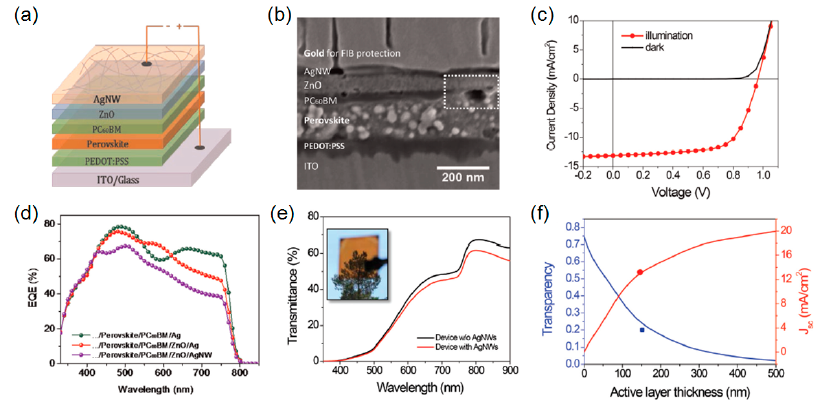
Figure 3. ( a ) Schematic structure of the devices with solution-processed top AgNWs. ( b ) Cross sectional SEM image of the whole device stack. The white dashed rectangle shows the area where perovskite is not covered by [6,6]-phenyl C 61 -butyric acid methyl ester (PCBM 60 ). ( c ) J - V curves of the devices measured under illumination (red curve) and in the dark (dark curve). ( d ) External quantum efficiency (EQE) characteristics of the three types of devices studied in this work. ( e ) Transmittance spectra of the device without and with AgNW top electrodes, which were measured before and after AgNWs deposition. The inset shows the photo of a complete semitransparent device. ( f ) Calculated transparency and J sc as a function of perovskite layer thickness. The blue and red dots are the experimental visible transparency (21.5%, corresponding to 28.4% AVT of the device) and J sc values. Reproduced with permission [10]. Copyright 2015, Royal Society of Chemistry. PEDOT:PSS: